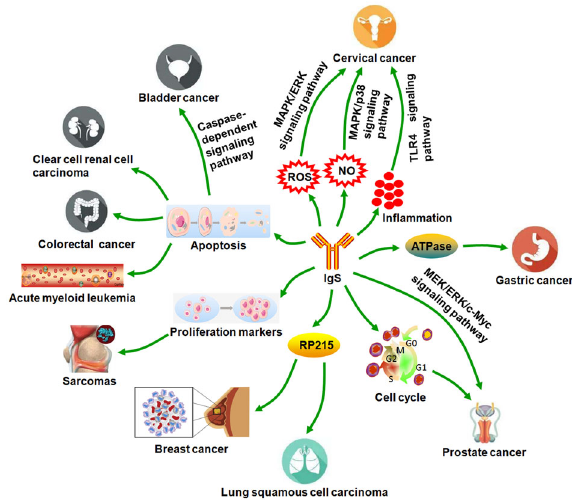
Fig. 4 Schematic illustration of the mechanisms that tumor- derived Igs promoted tumor cell growth and proliferation. Tumor- derived Igs augmented multiple tumor cell growth and prolifera- tion through positively or negatively regulating the following cell signaling pathways or biological processes or important molecules, including MAPK/ERK signaling pathway, MAPK/p38 signaling path- way, TLR4 signaling pathway, MEK/ERK/c-Myc signaling pathway, caspase-dependent signaling pathway, apoptosis, cell cycle, ATPase, and proliferation markers. Tumor-derived IgG speci fi cally recognized by RP215 promoted cancer (breast cancer and LSCC) cell